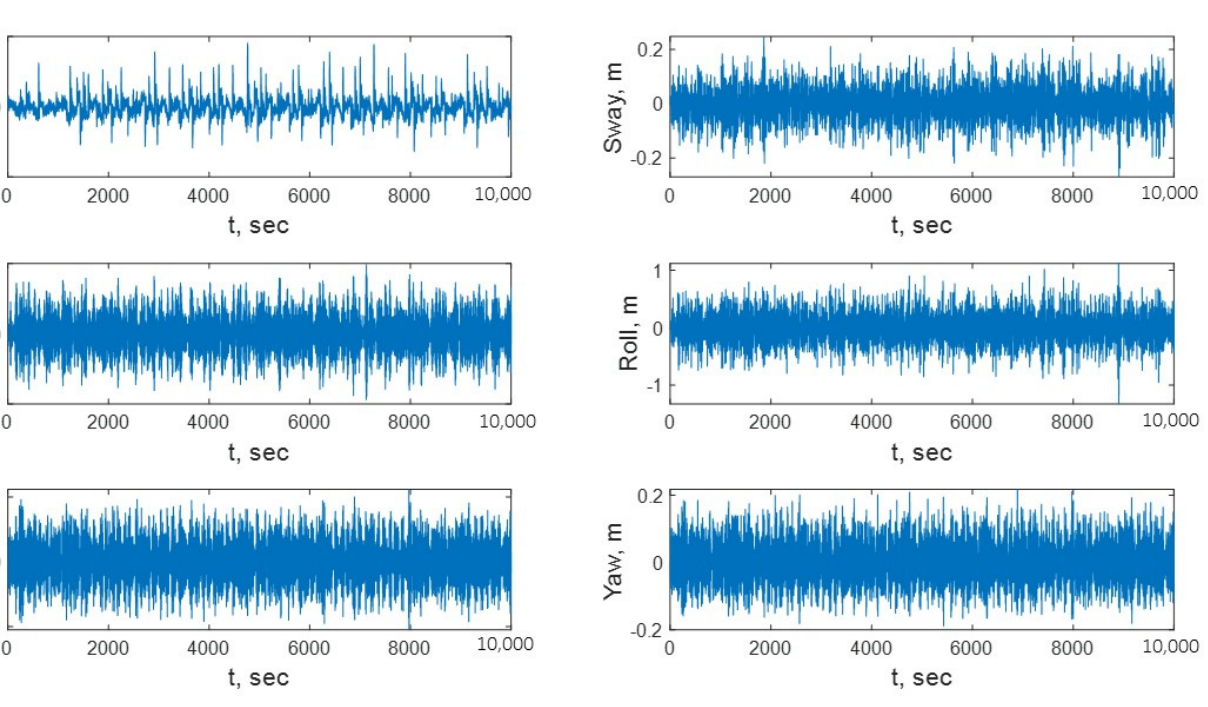
Figure A1. Load case c1 (H mo = 2 m)—wave frequency position. The surge and sway positions are relative to the position of the Delta, the other positions are absolute position of the ship.